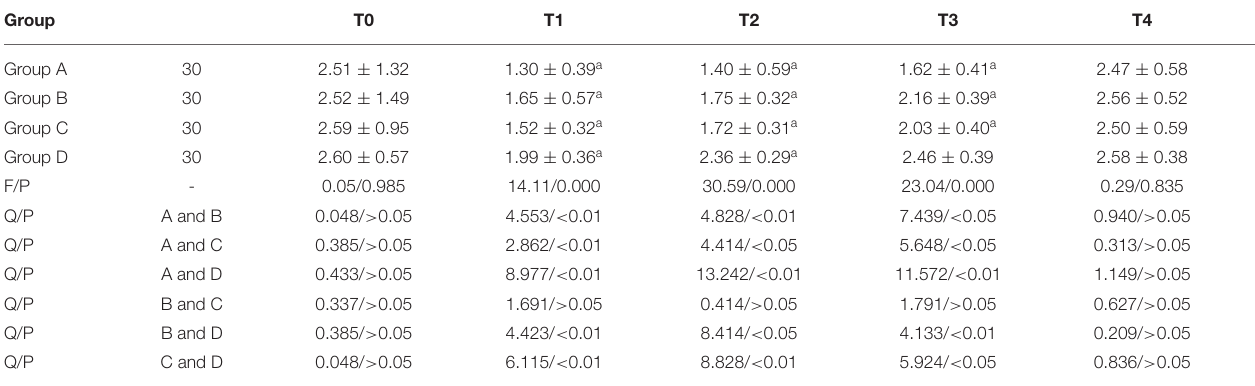
TABLE 3 | Comparison of CD4 + /CD8 + expression among four groups ( ¯ X ±